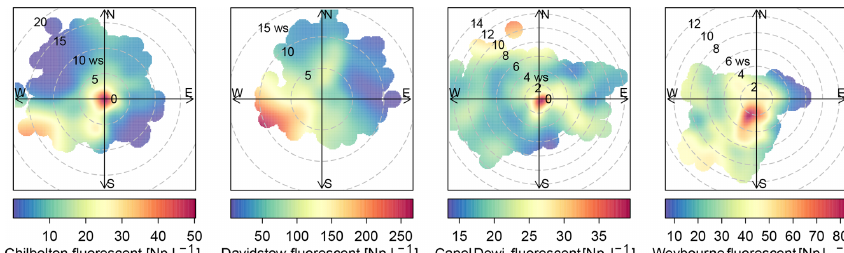
Figure 5. Total fluorescent particle concentration at each site for each campaign period (number of particles, N p , in units of L − 1 ).